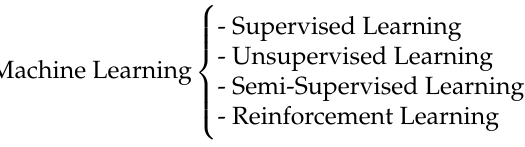
Figure 1. Machine learning